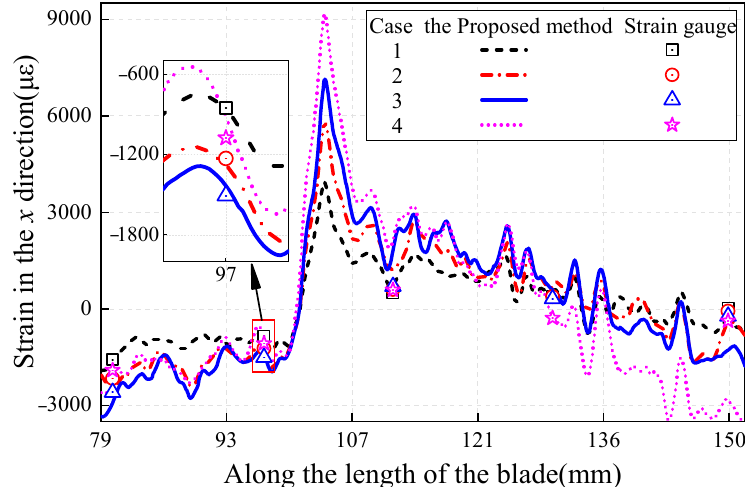
Figure 9. Strain curve along the length of the blade.